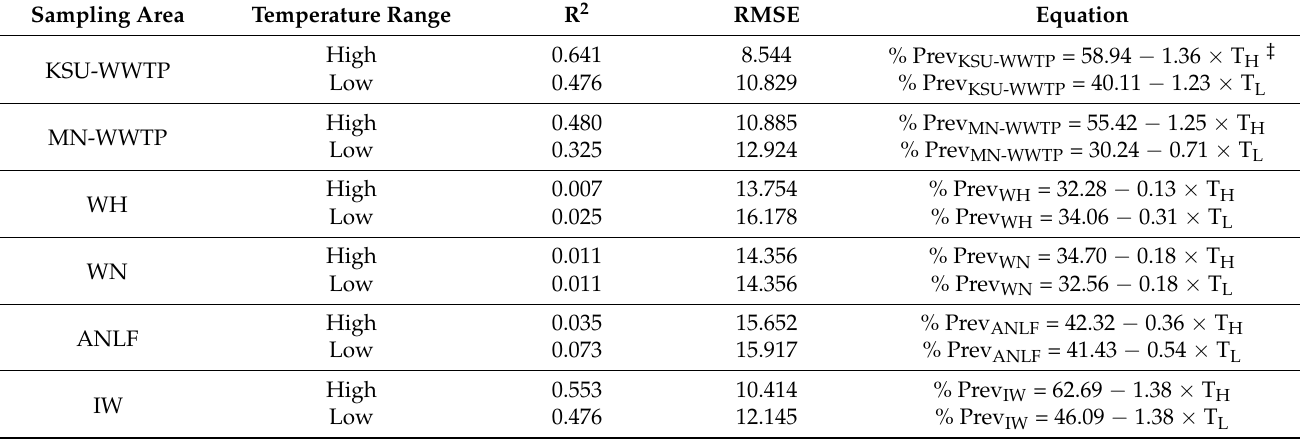
Figure 4. The impact of temperature variation on HAdV prevalence. Av. High Temp., the average high temperature; Av. Low Temp., the average low temperature. Table 3. The significance of the influence of high or low-temperature ranges on HAdV prevalence in various sampling areas. Sampling